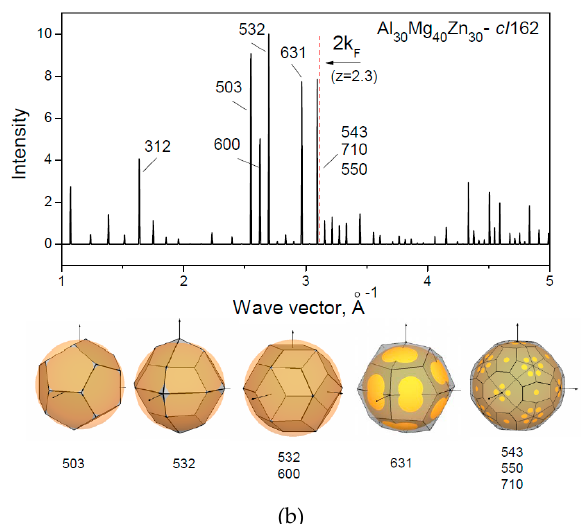
Figure 2. Calculated diffraction patterns for quasicrystal approximants (upper panel) and corresponding Brillouin-Jones zones with the Fermi spheres (lower panel). The position of 2 k F for a given valence electron number per atom z and the hkl indices of the planes used for the BZ construction are indicated on the diffraction patterns. ( a ) CaCd 6 - cI 168; and ( b ) Al 30 Mg 40 Zn 30 - cI 162. Structural data and FS–BZ evaluation data are given in Table 1.